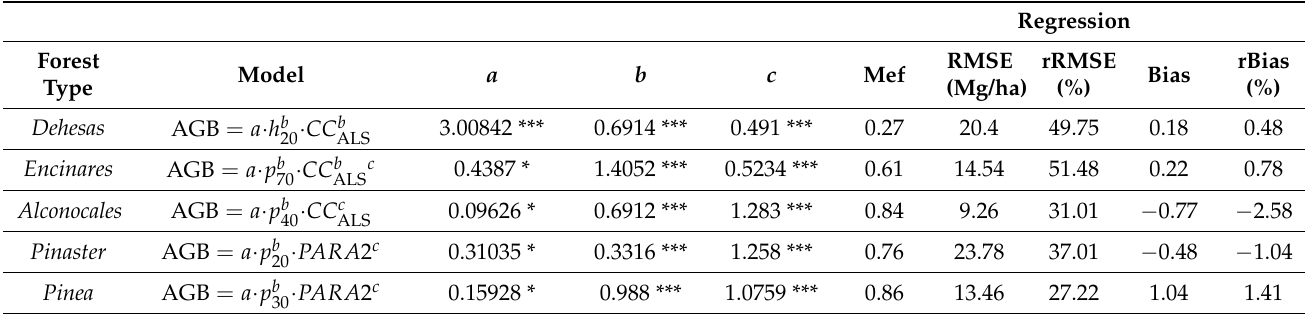
Table 5. Summary of the ALS-based AGB prediction models and plot-level accuracy assessment obtained for Dehesas , Encinares , Alcornocales, Pinaster, and Pinea forest ecosystems.